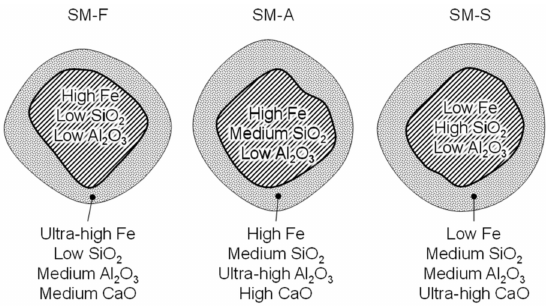
Figure 15. Granule structure within different